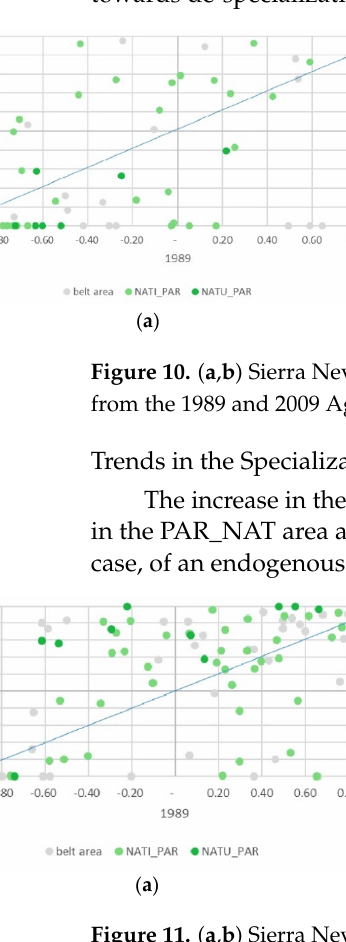
( b ) Figure 12. ( a , b ) Sierra Nevada- PSI and DPSI of goats. Source: Drawn up by the authors using data from the 1989 and 2009 Agrarian Censuses, Ministry of Agriculture. Trends in the Specialization in Pigs and Horses (1989–2009) Pig and horse farms declined sharply over the study period, with widespread de- specialization in almost all the municipalities in both areas of the park (Table 4). Table 4. Trends in specialization according to the types of livestock (1989–2009). Breeding PAR_NAC PSI